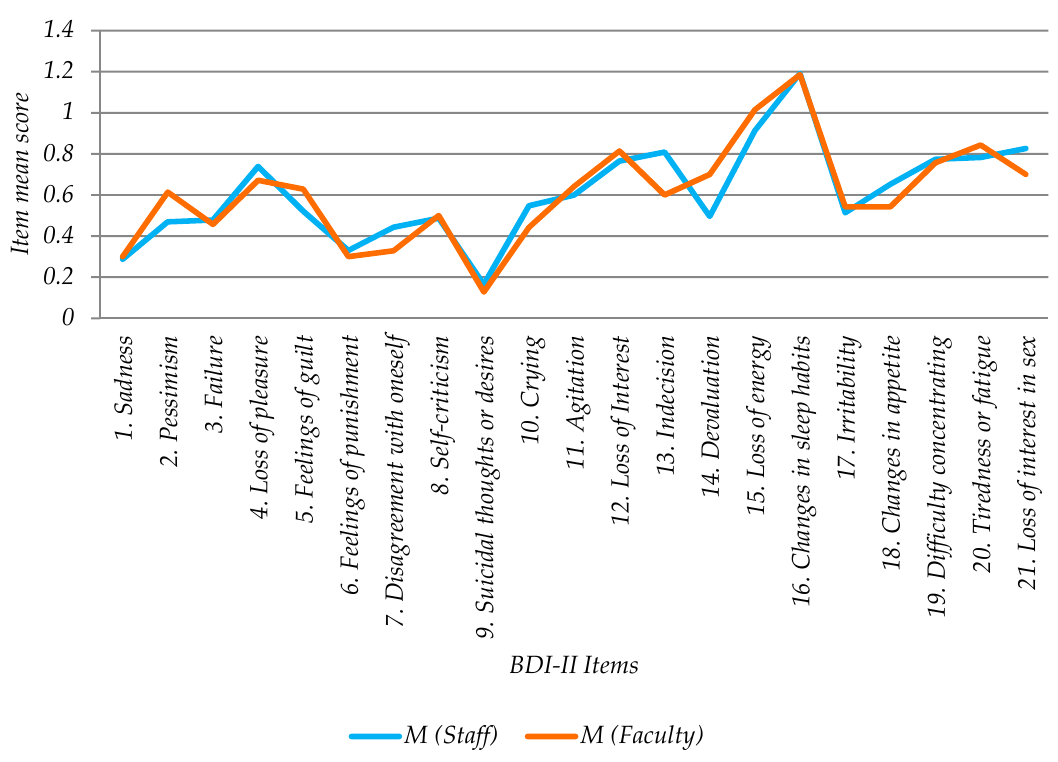
Figure 10. Mean scores (M) of responses by group.